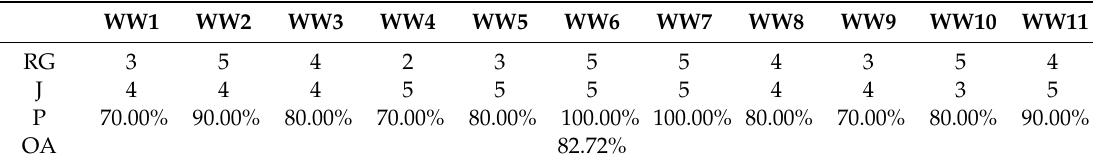
Table 3. Statistical results of the winter wheat sample